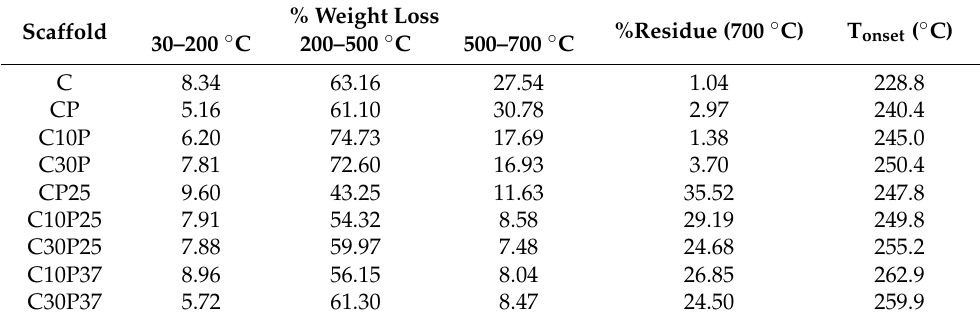
Figure 7. TGA curves for (a) C30P37; (b) C30P25; (c) C30P; and (d) C. Table 3 summarizes the weight loss percentage at each step, the onset of scaffold degra- dation, and the residue after carbonization in each sample, which allows the quantification of the mineralization process. Table 3. Percentage of weight loss at different temperature range, residue percentage, and T onset of scaffolds, obtained through TGA .